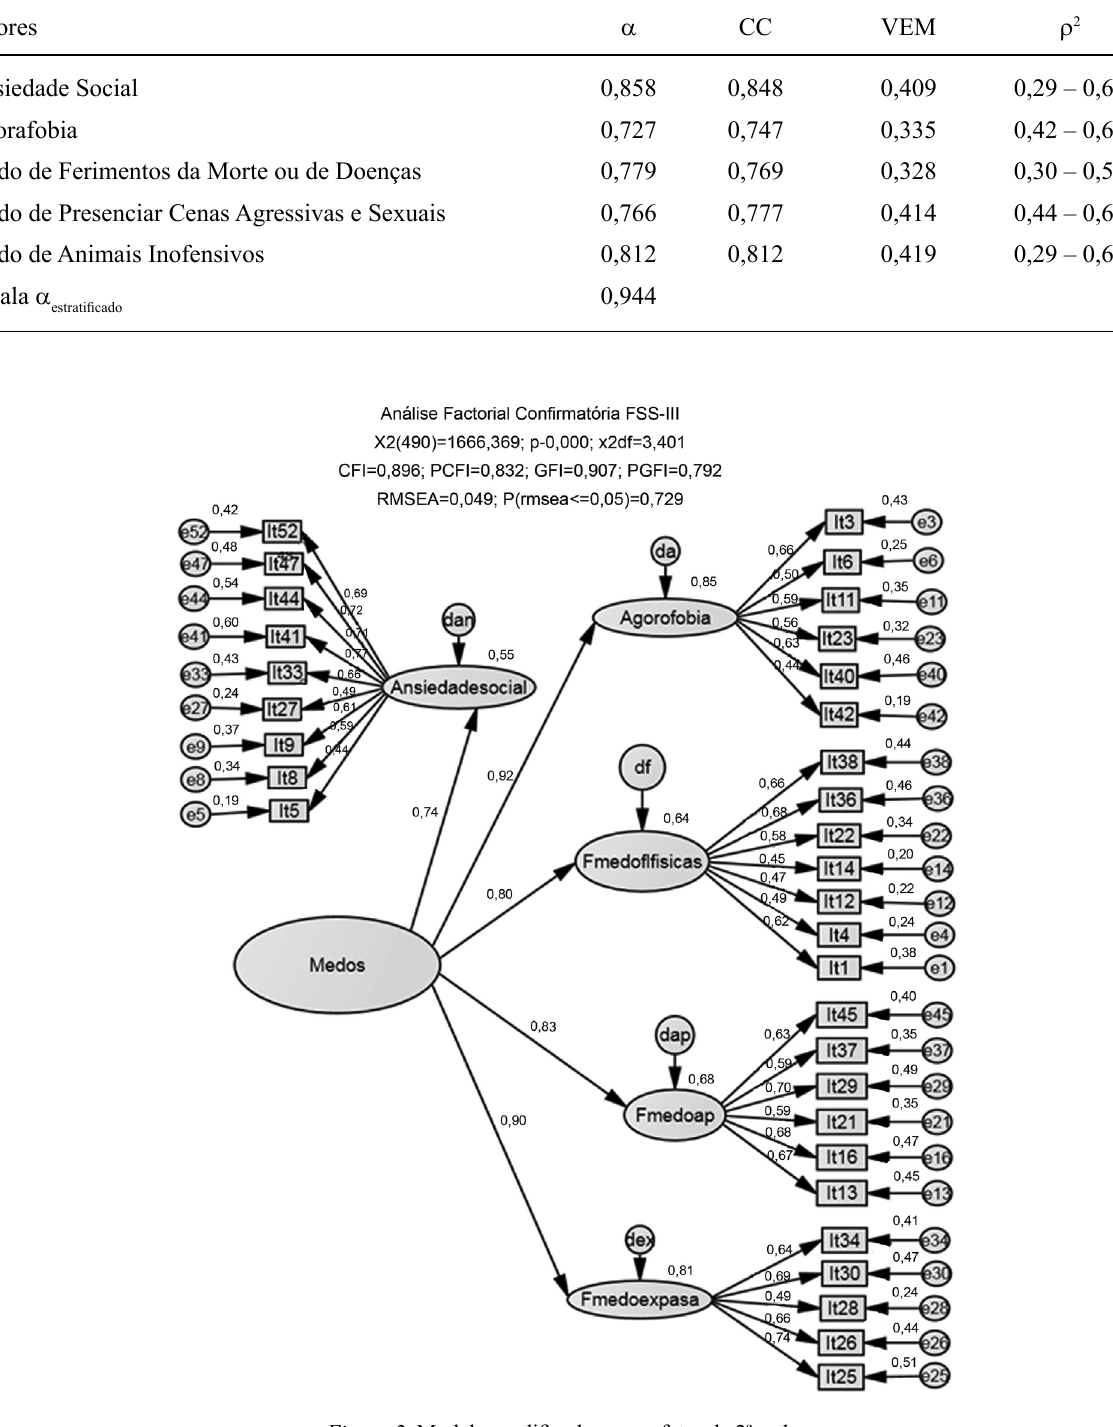
Figura 2. Modelo modi fi cado com o fator de 2ª